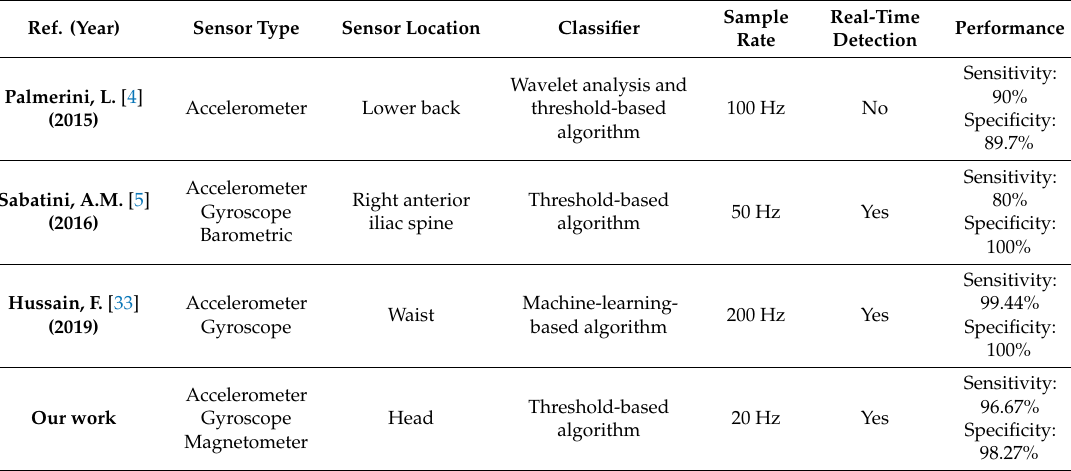
Table 5. Comparison between proposed and previously developed fall detection